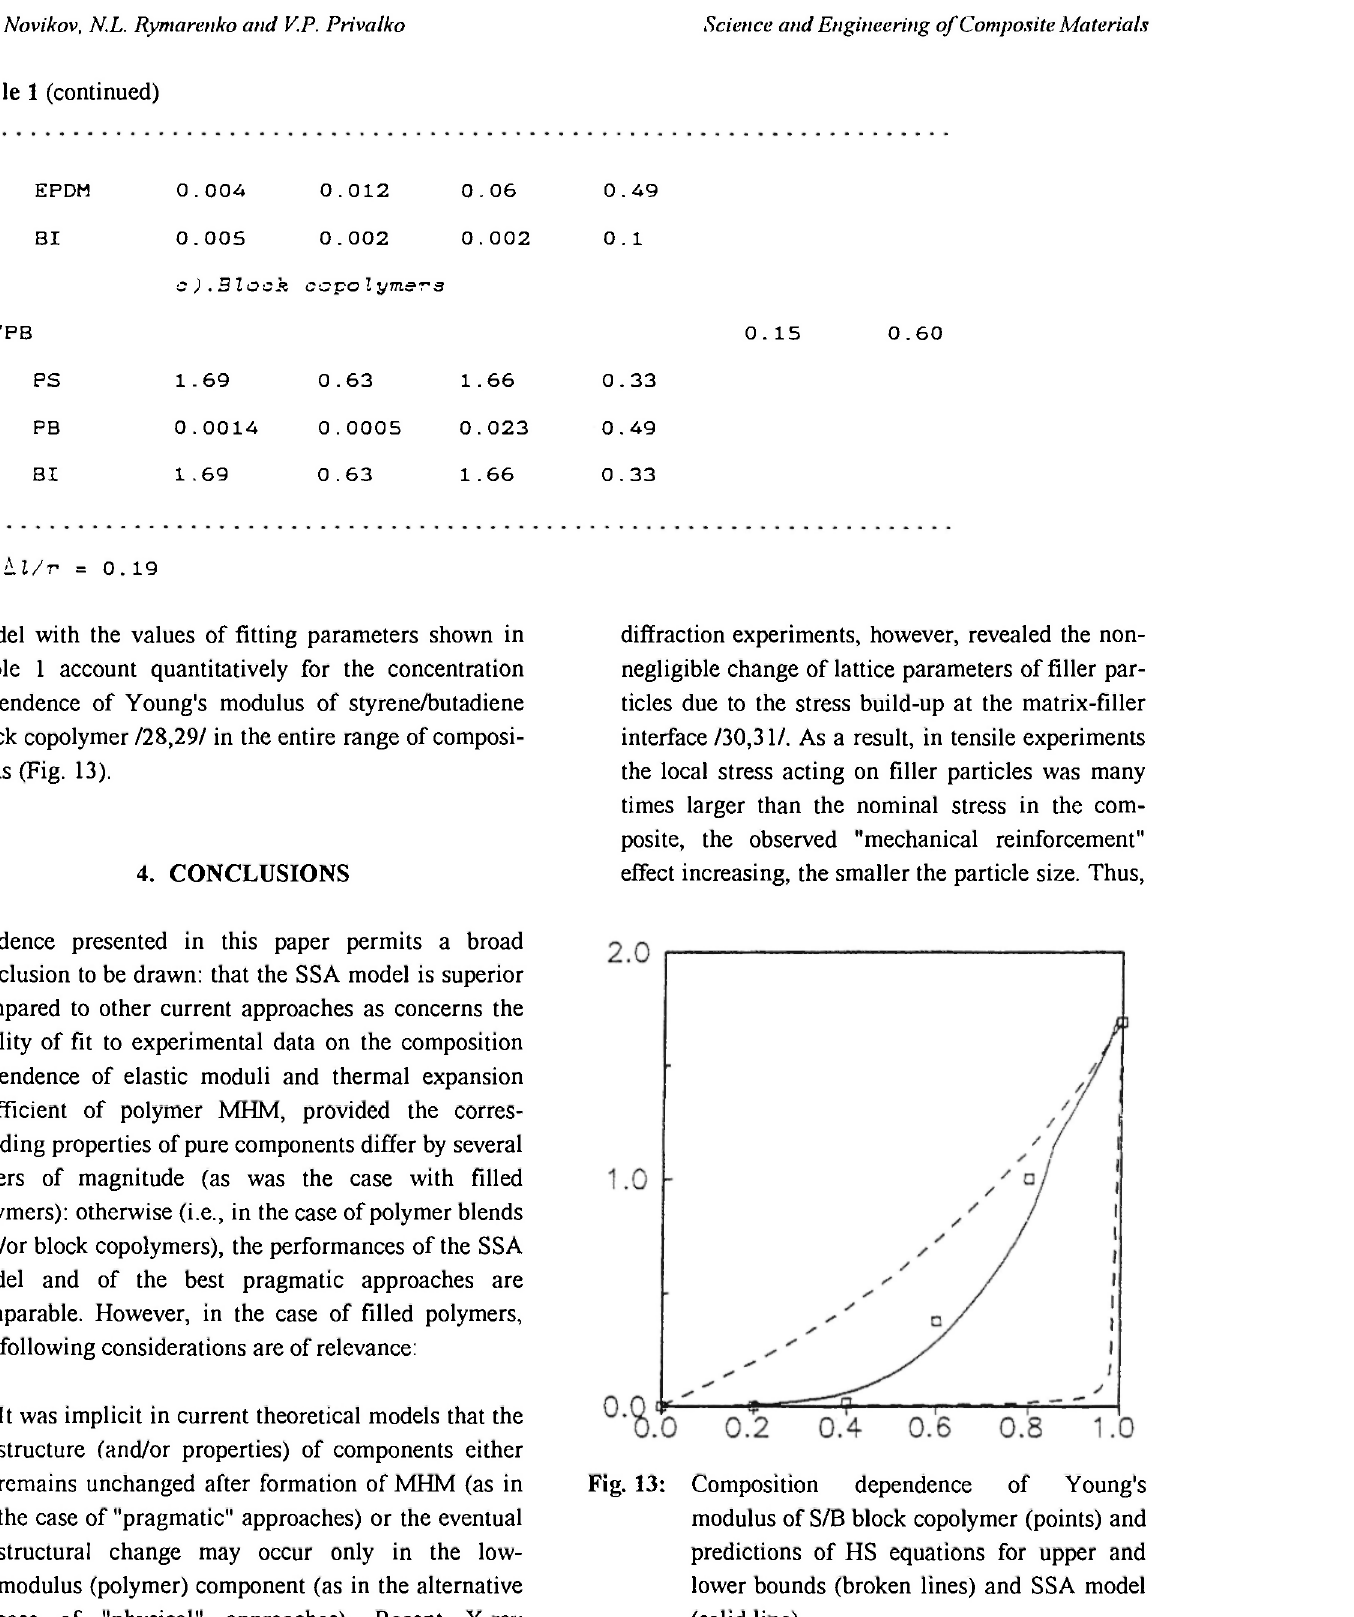
Fig. 13: Composition dependence of Young's modulus of S/B block copolymer (points) and predictions of HS equations for upper and lower bounds (broken lines) and SSA model (solid line).